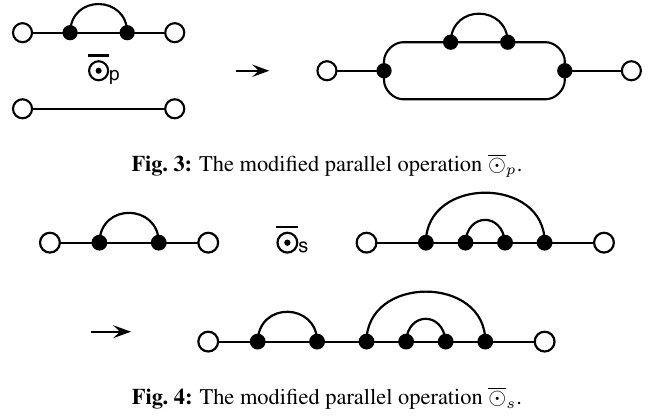
Fig. 4: The modified parallel operation (cid:12) s